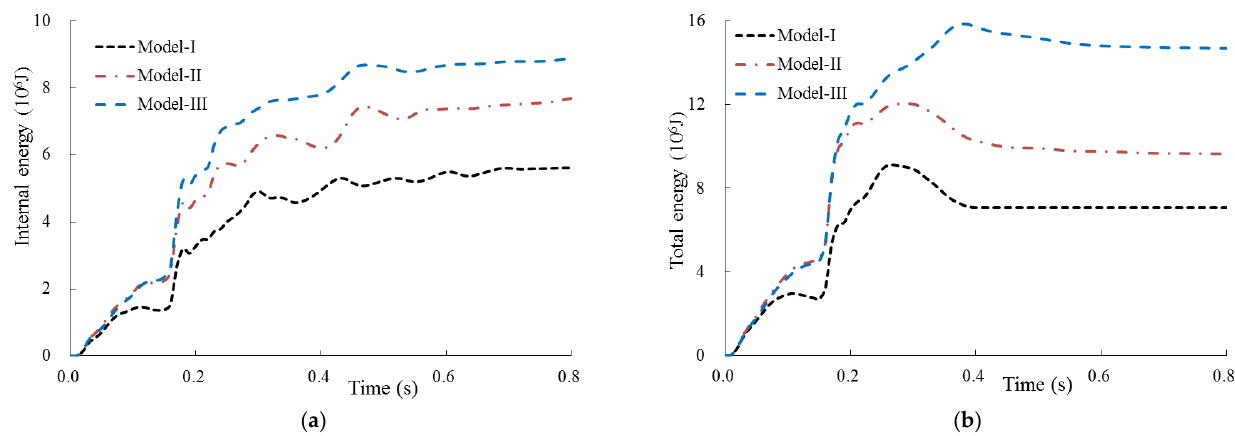
Figure 9. The internal energy of concrete and total energy of containment for different models. ( a ) Internal energy; ( b ) Total energy.